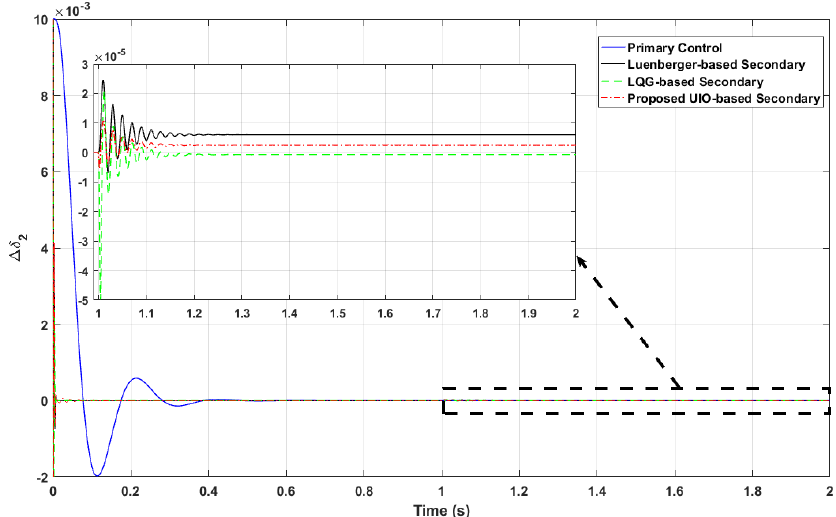
Figure 6. Second inverter angle δ 2 in scenario 1 (Step load change).